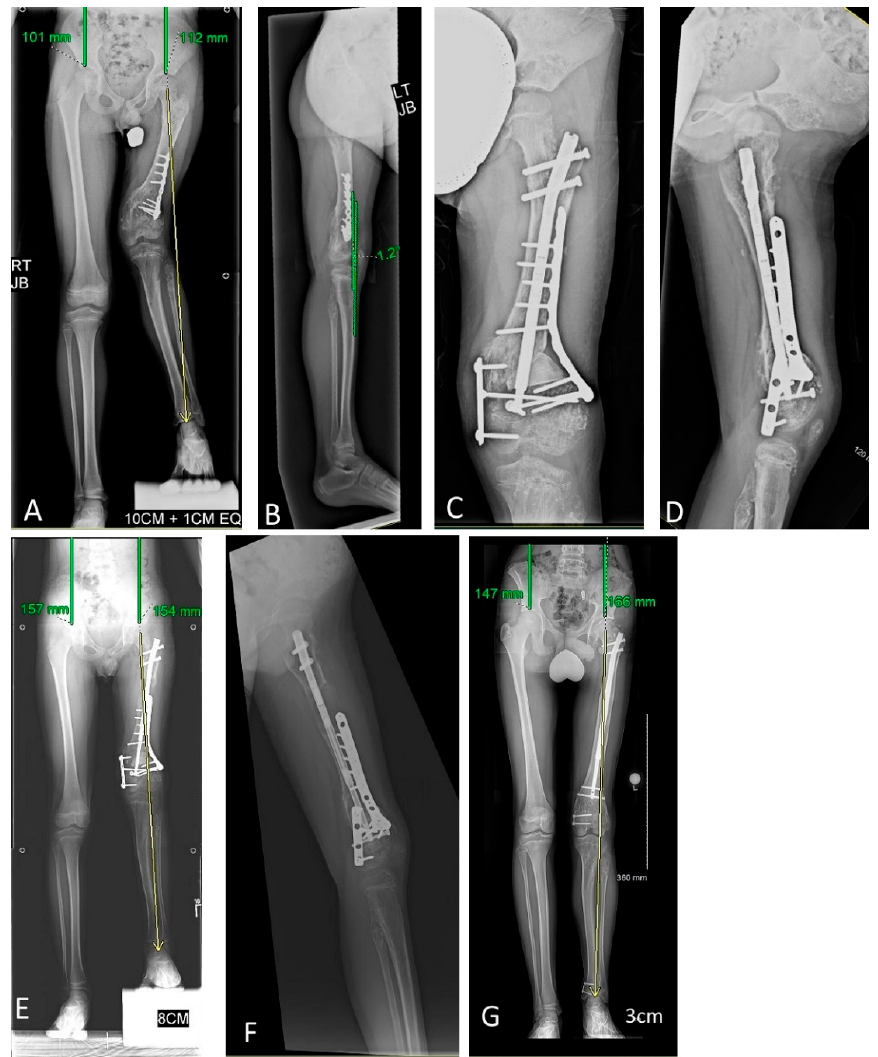
Figure 3. Acute coronal plane deformity correction with simultaneous intramedullary